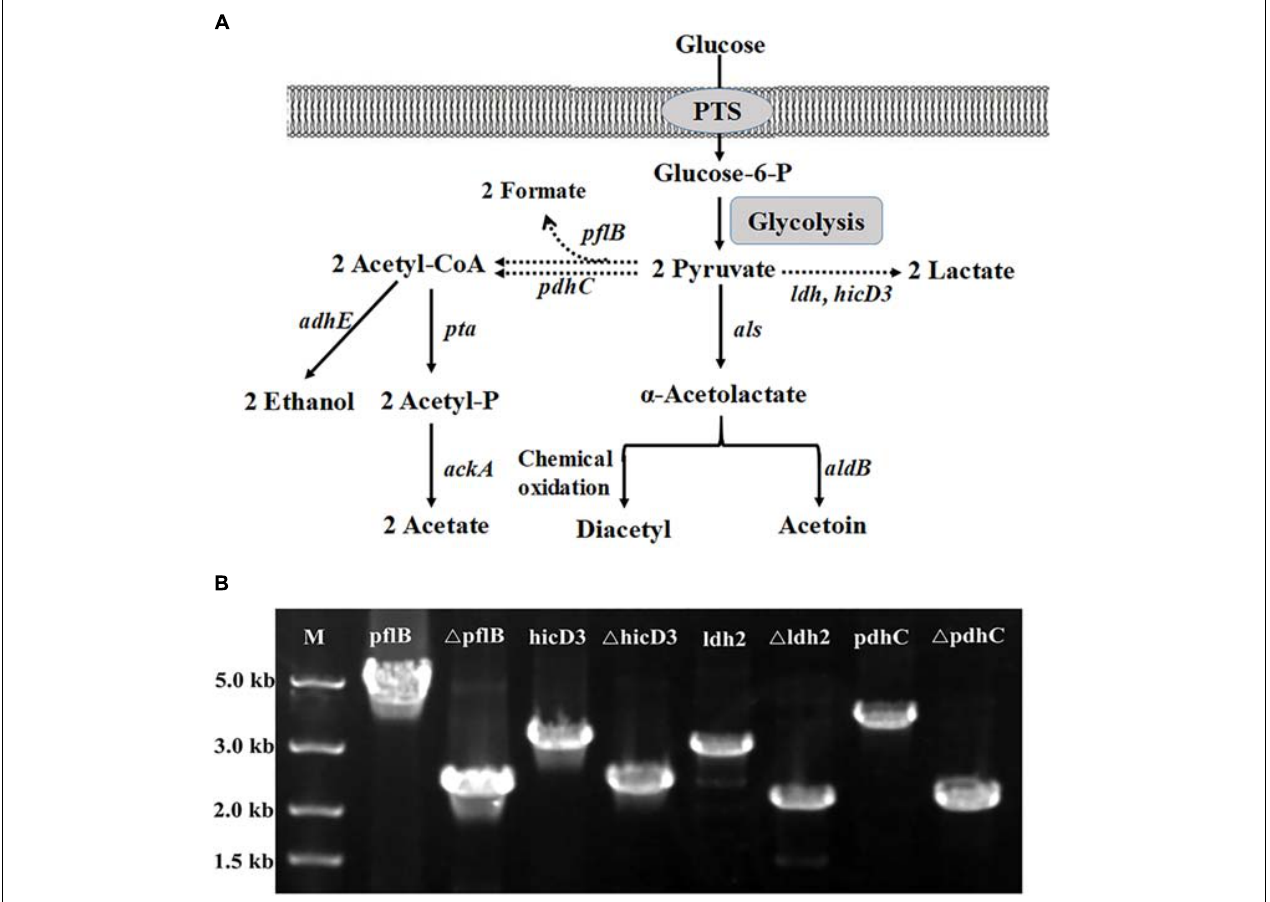
FIGURE 4 | Metabolic pathways associated with acetoin biosynthesis in L. casei . (A) The metabolic engineering strategies for aerobic acetoin overproduction. The dashed arrows indicated that the pathways were disrupted. ldh , encoding Lactate dehydrogenase; als , encoding α -acetolactate synthase; aldB , encoding acetolactate decarboxylase; pdhC , encoding pyruvate dehydrogenase complex E2 component; pflB , encoding pyruvate formate lyase; adhE , encoding alcohol dehydrogenase; pta : encoding phosphate acetyltransferase; ackA : encoding acetate kinase. PTS, phosphotransferase system. (B) One colony of the BL27 strain was selected to be tested by PCR with the forward primer of the up homology and the reverse primer of the down homology after Cre recombinase induction and incubation. The expected PCR fragment from the deletion type is about 2.0 kb, while the wild-type is approximately 5.0 kb for pflB and 3.0 kb for hicD3 , ldh , pdhC .